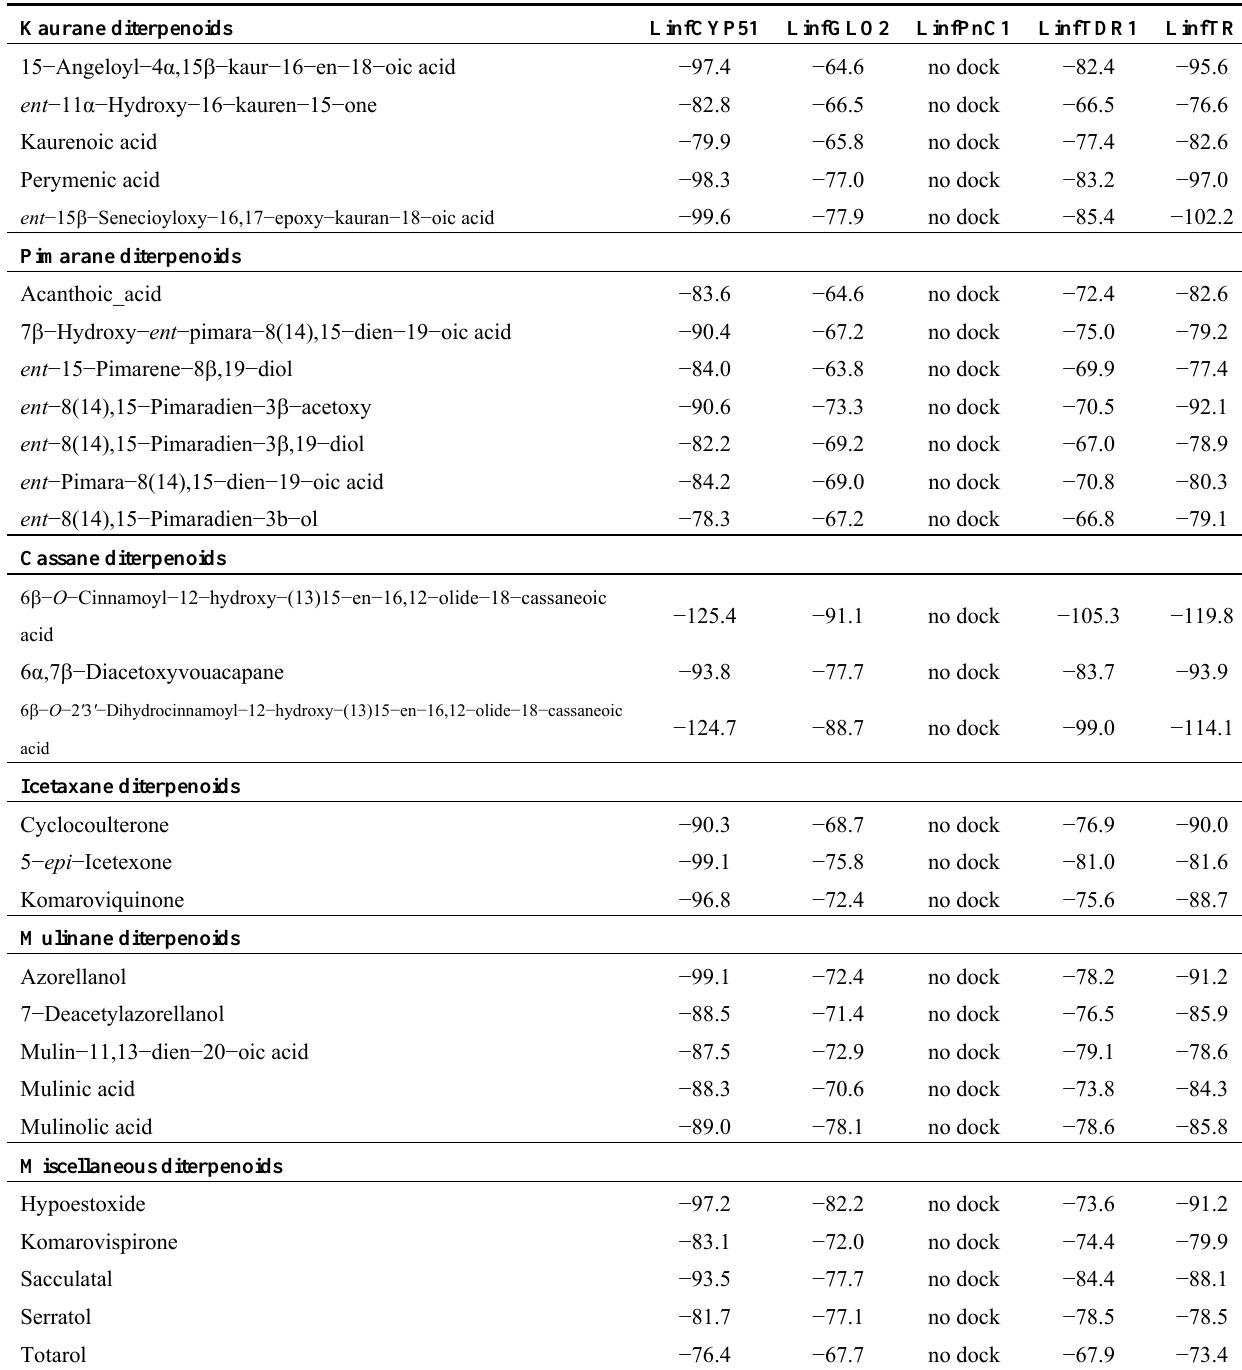
Table 28. MolDock docking energies (kJ/mol) of miscellaneous diterpenoids with Leishmania infantum protein